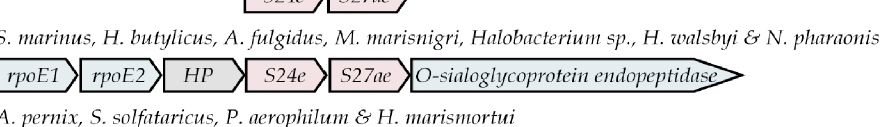
Figure 4. Alternative versions of the S24e - S27ae gene cluster in Archaea. Notation is as in Fig- ure 1. The hypothetical protein is indicated as